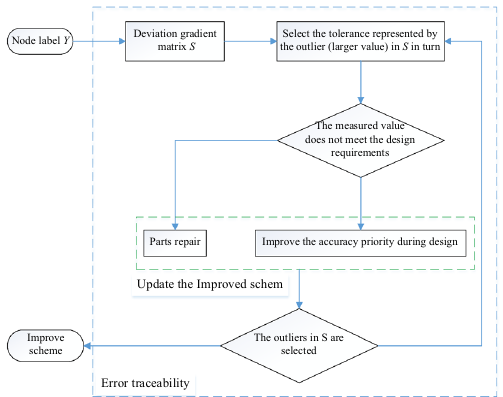
Figure 6. Error traceability process.